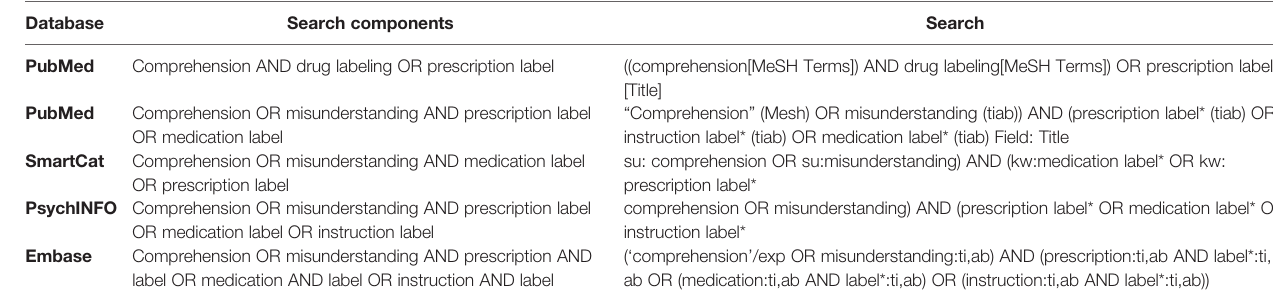
TABLE 1 | Search strategy in electronic